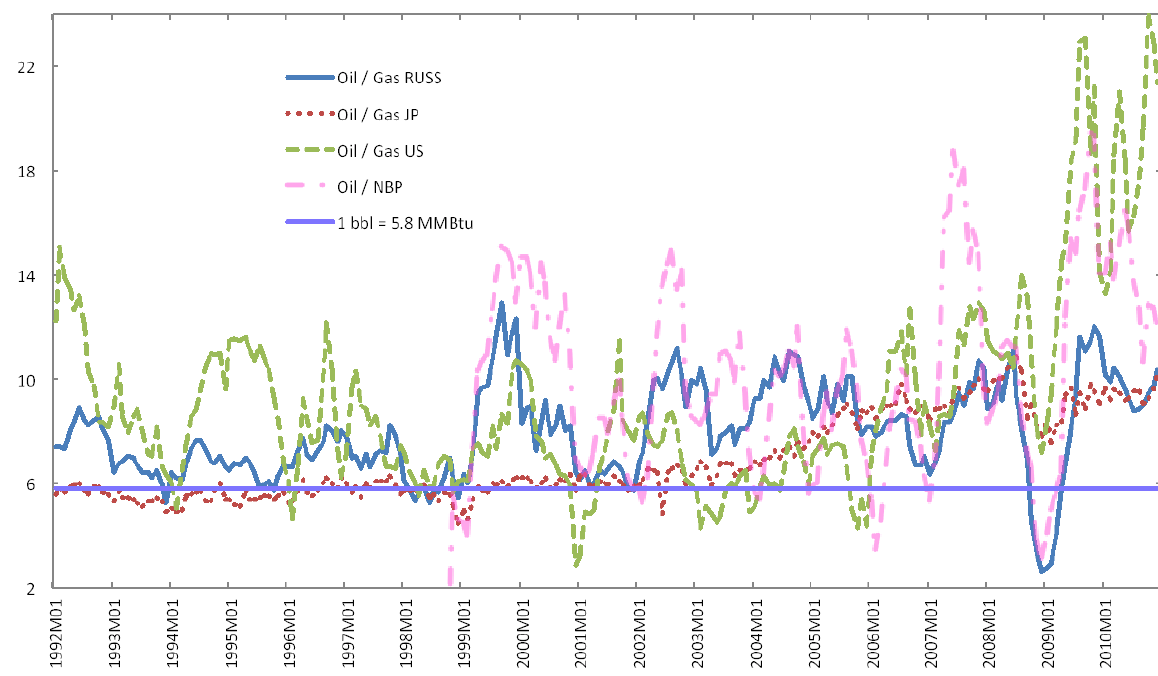
Figure 2. The Russian natural gas (bold line), Japanese LNG (dotted line), US natural gas (dashed line) and UK natural gas (dashed-dotted line) prices compared to crude oil price and thermal